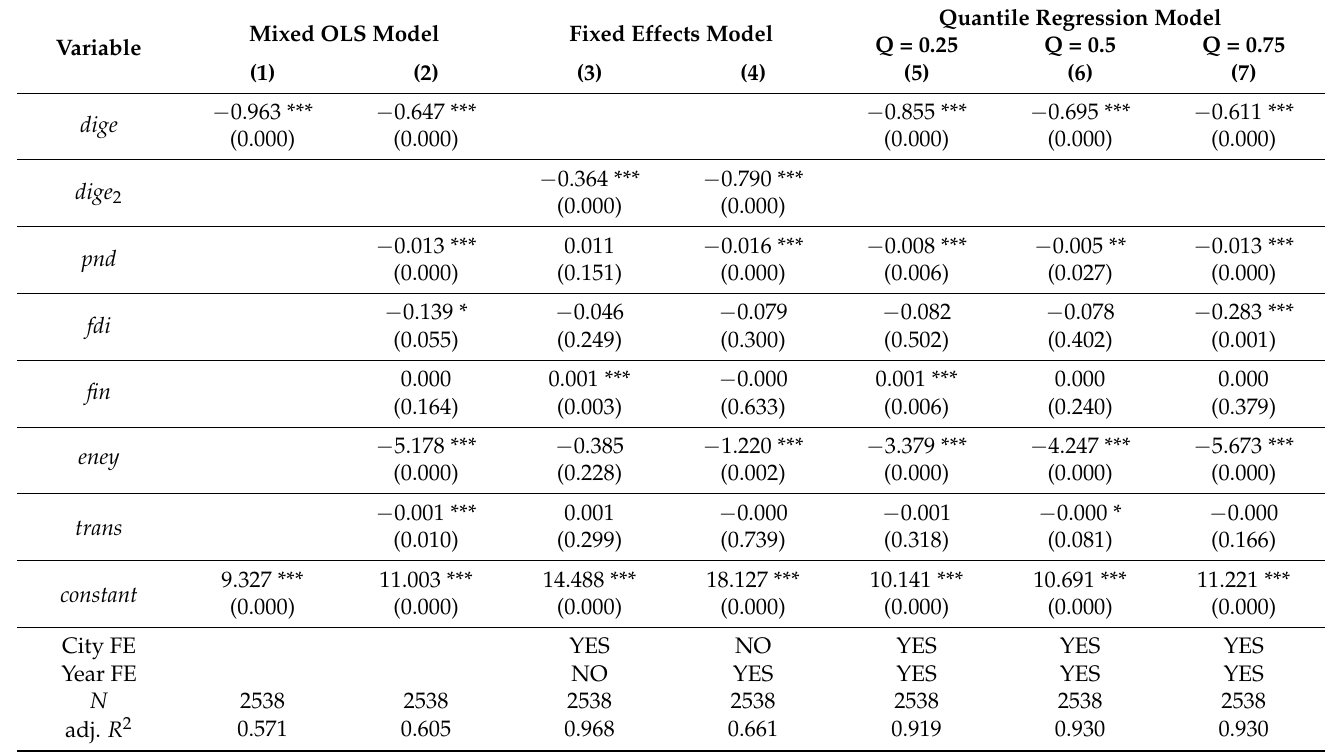
Table 5. Robustness test